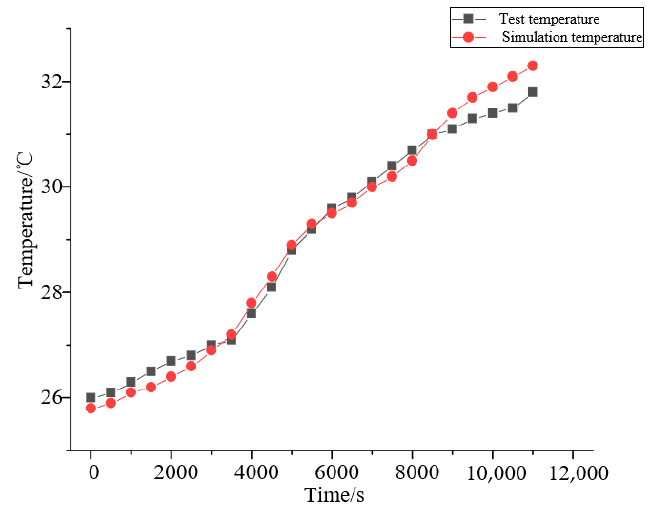
Figure 15. Temperature rise comparison between the measured and simulated results.